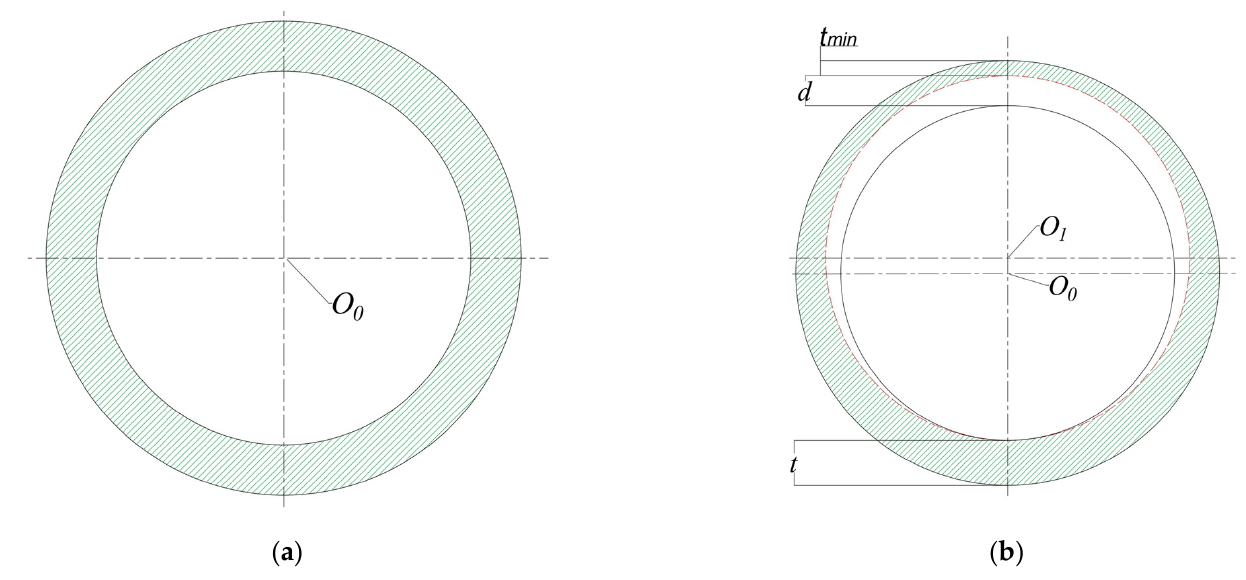
Figure 2. ( a ) Unflawed pipe; ( b ) DCA model of corroded supercritical CO 2 pipeline.